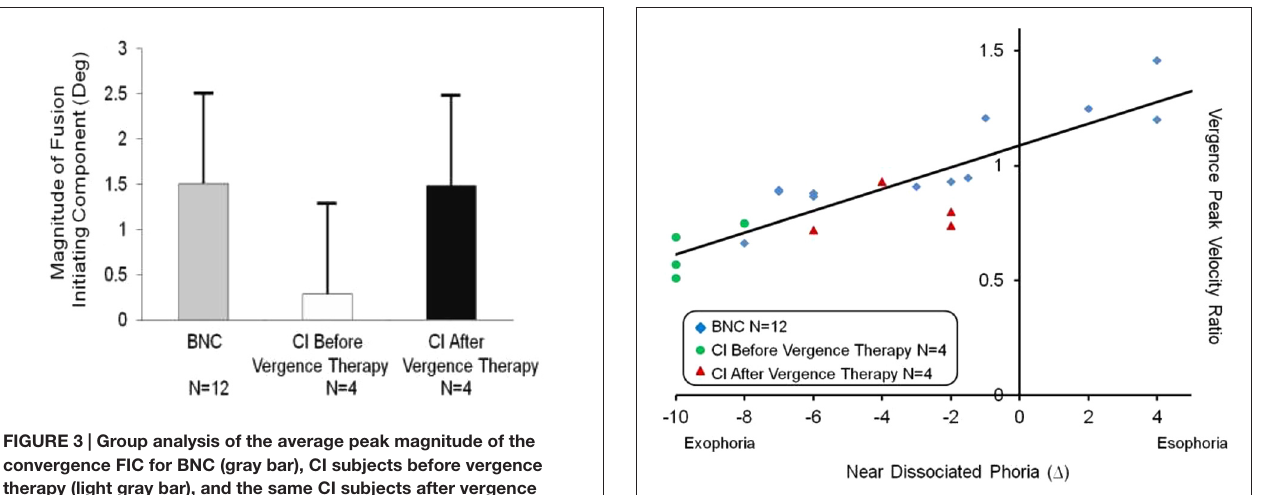
FIGURE 4 | Linear regression analysis of the vergence peak velocity ratio (average convergence peak velocity divided by average divergence peak velocity) as a function of the near dissociated phoria. Esophoria is denoted as positive and exophoria is denoted as negative. The BNC, CI subjects before vergence therapy and the same CI subjects after vergence therapy are shown in blue diamonds, green circles and red triangles, respectively. A significant correlation was observed ( p < 0.01) and the Pearson correlation coefficient was r =